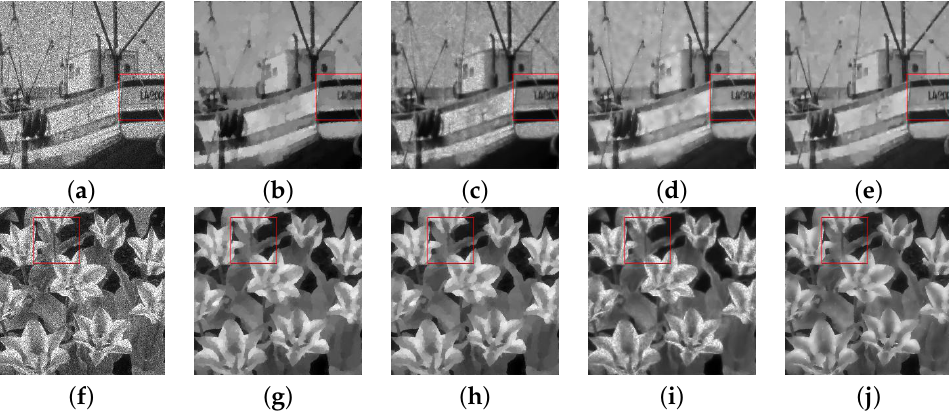
Figure 5. Recovery results of four algorithms on different images with the noise at L = 20: ( a ) De- graded. ( b ) CONVEX. ( c ) OGSTVD. ( d ) M-TGV. ( e ) NHOGSHL. ( f ) Degraded. ( g )